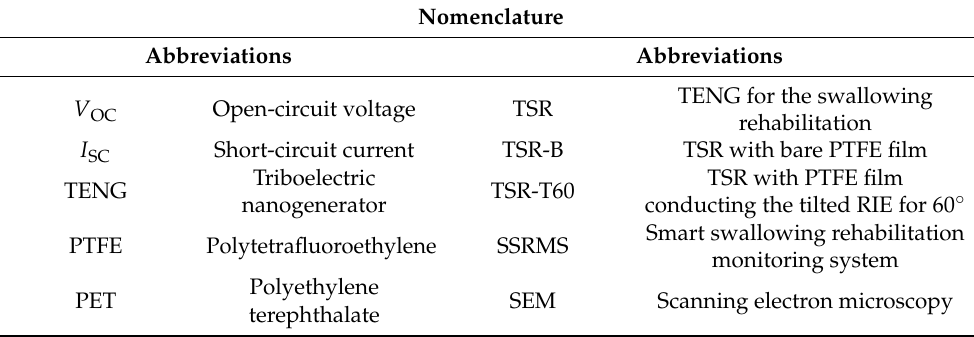
Table 1. Nomenclature of the abbreviations.